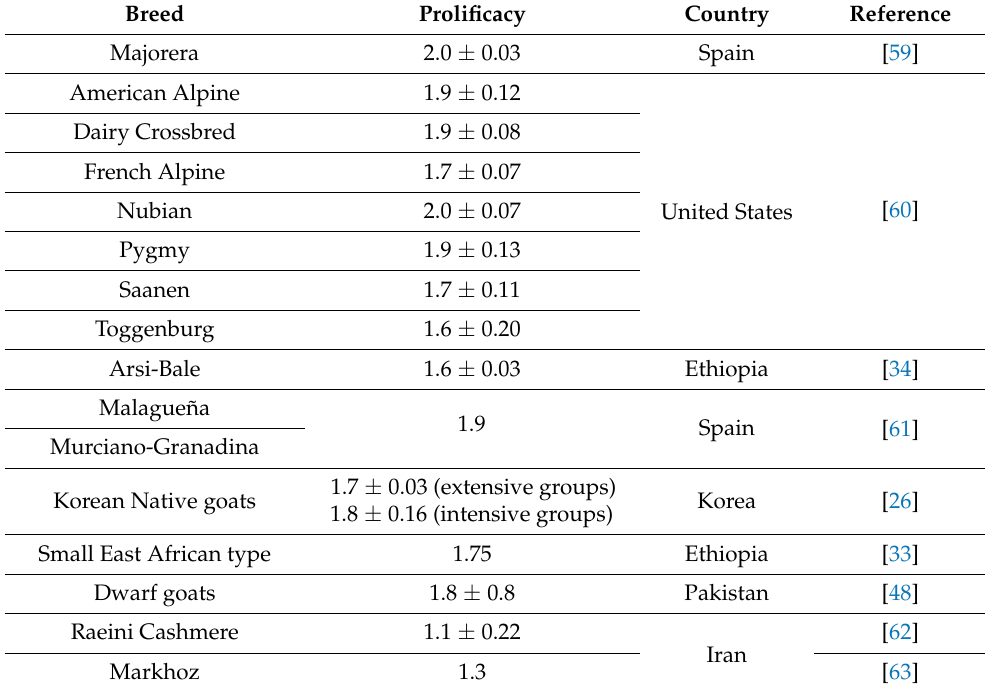
Table 7. Prolificacy of several local goat